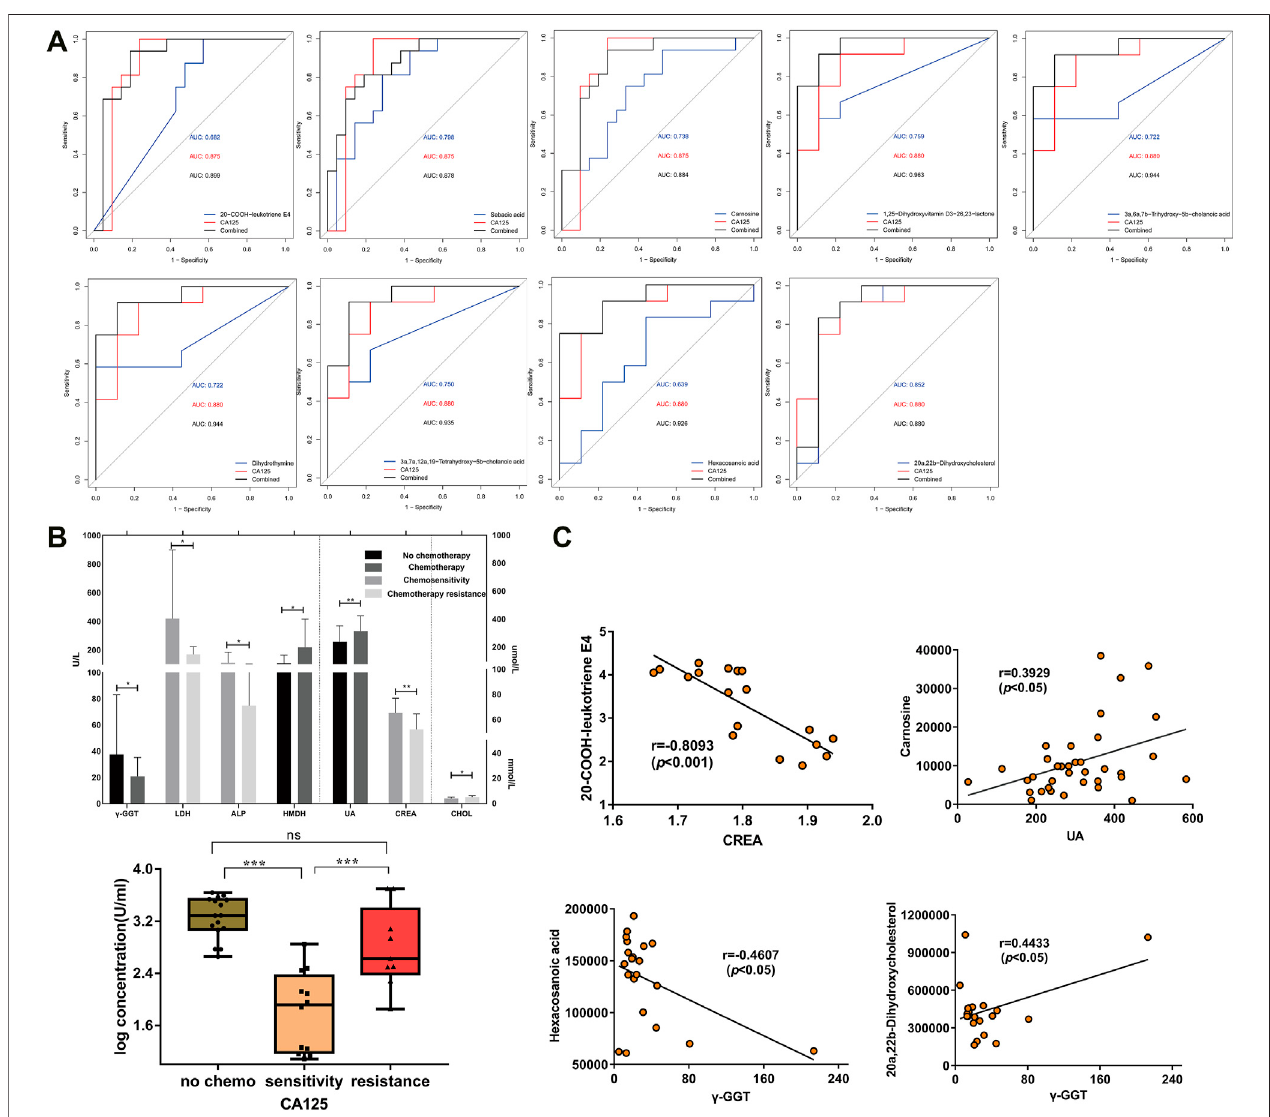
FIGURE 3 | Analysis of differential metabolites and clinical data of patients. (A) ROC curves of nine metabolites combined with CA125 respectively. (B) The expression ofserologicalmarkesinnon-chemotherapygroupvschemotherapygroupandchemotherapy-sensitivitygroupvschemotherapy-resistant group( p < 0.05). The ordinate is the concentration (log). γ -GGT: γ -Gltamyltranspeptidase; LDH: Lactic dehydrogenase; ALP: Alkaline phosphatase; HBDH: Hydroxybutyrate dehydrogenase; UA: Uric Acid; CREA: Creatinine; CHOL: Cholesterol. (C) Correlation analysis scatter plot for 20-COOH-LTE4 and creatinine, carnosine and uric acid, 20a, 22b-dihydroxycholesterol, hexadecanoic acid and γ -GGT ( p < 0.05).